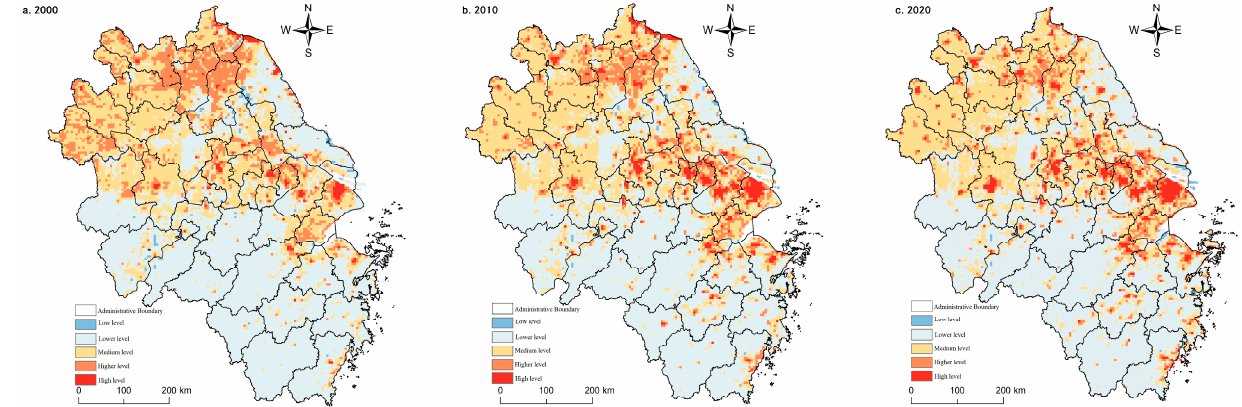
Figure 5. Spatial pattern of living functions in the Yangtze River Delta from 2000 to 2020.